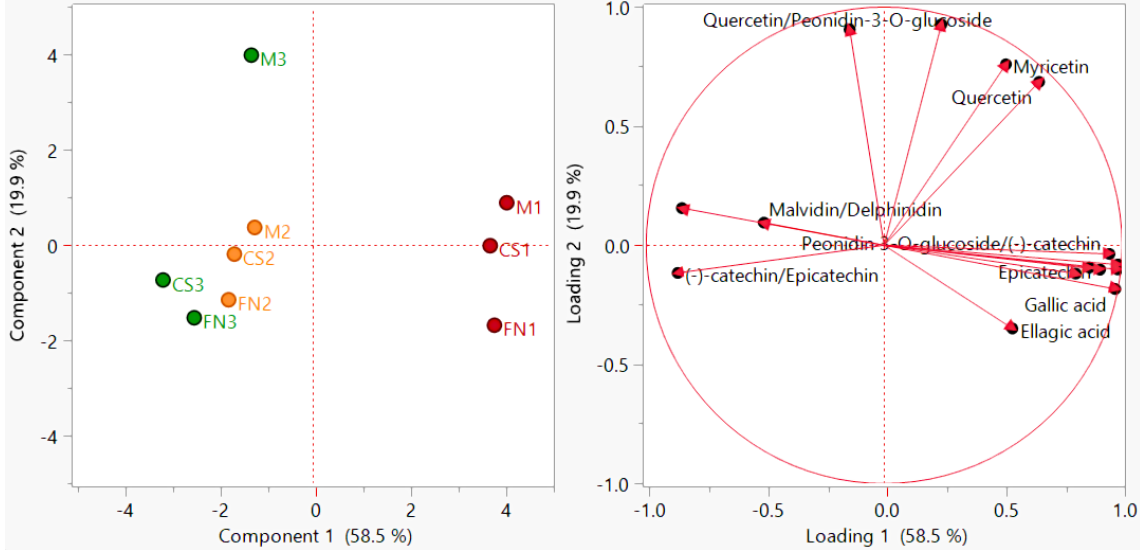
Figure 4. PCA diagram—improved sample grouping (scores plot) and polyphenol distribution (loadings plot) for Stage 1 wines. Color coding: red—Murfatlar 2014; orange—Murfatlar 2015; green—Valea Călugărească 2015.